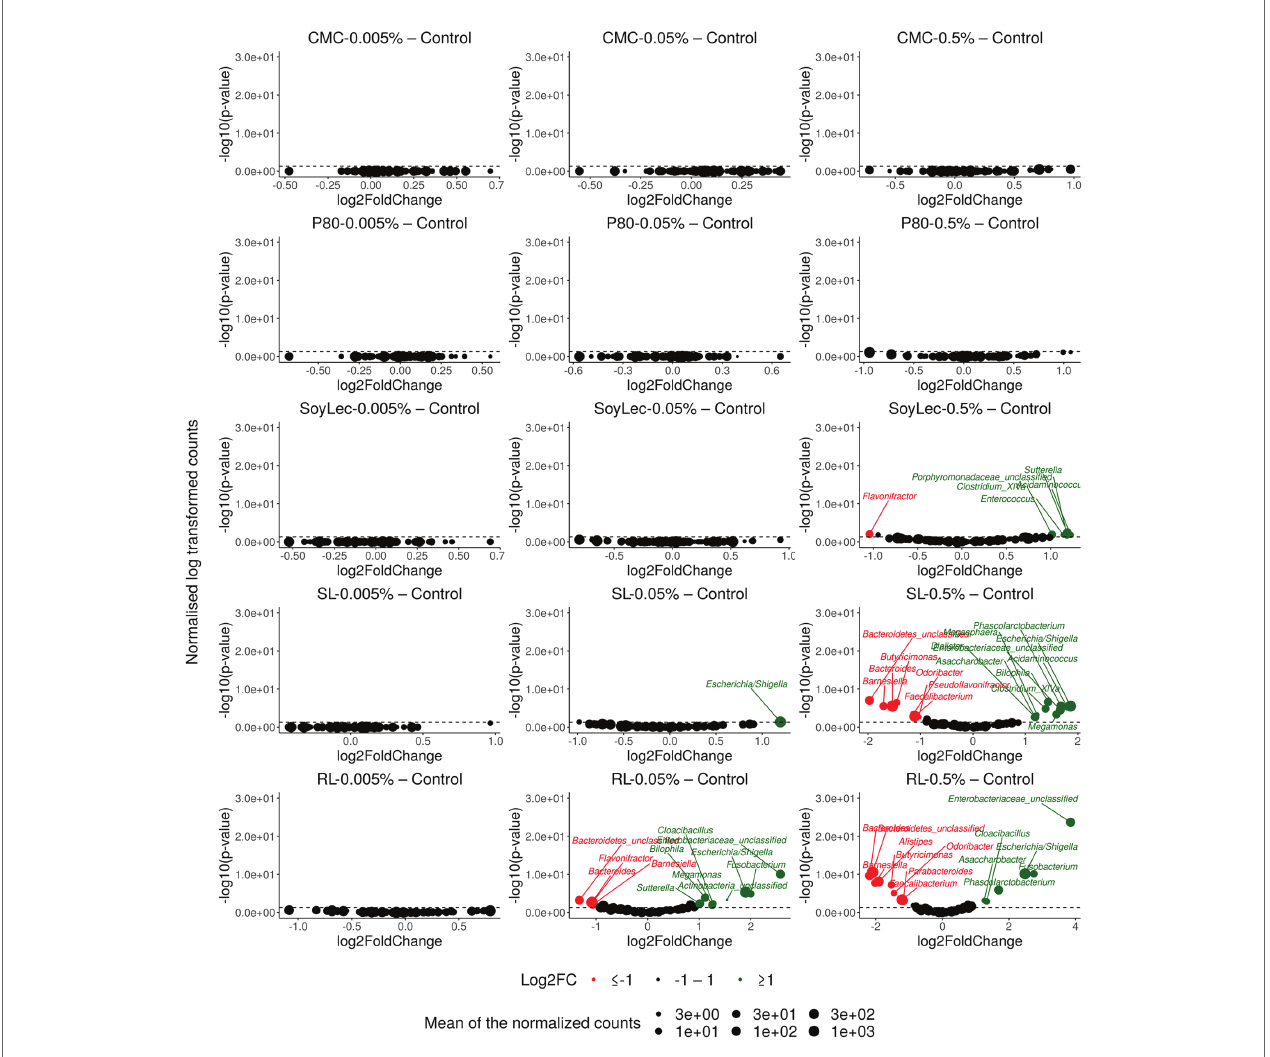
FIGURE 5 | Volcano plots indicating gut microbial community alterations after 48 h of in vitro batch incubations of fecal material from 10 donors with sugar depleted medium supplemented with five emulsifiers at four concentrations. Samples were taken upon incubation (T0; 2–3 h after inoculation) as well as after 24 h (T1) and 48 h (T2) of incubation. Log2FoldChange (L2FC) of genus abundances for all emulsifier treatments vs. the control are presented on the x -axis and the log transformed adjusted p -value is presented on the y -axis. Significantly increased or decreased genera are indicated in respectively green and red. The dashed line represents the significance threshold of α =